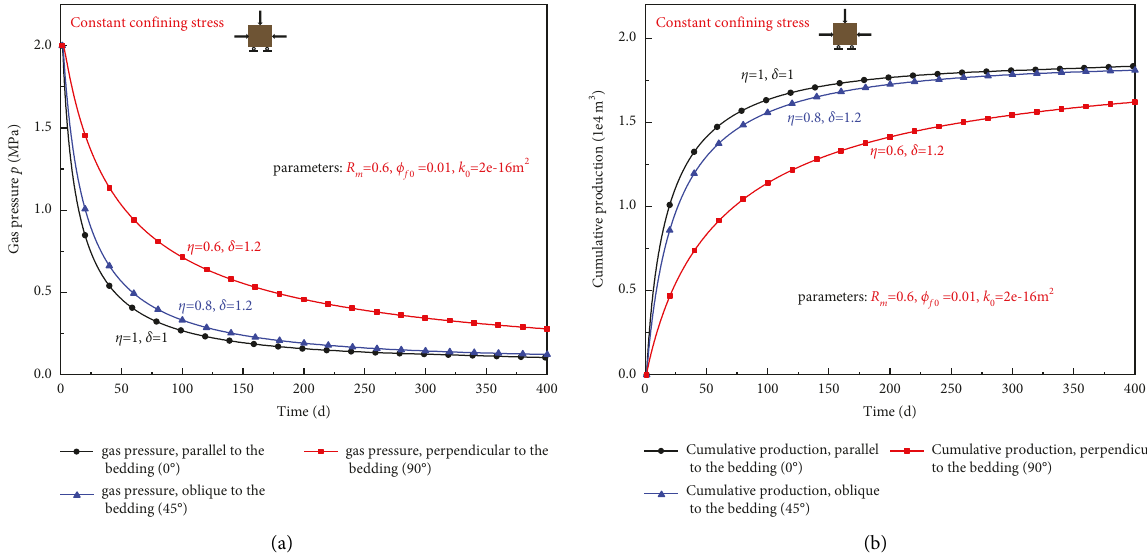
Figure 9: (a) Gas pressure as a function of time and (b) cumulative gas production forecast as a function of time under constant stress boundary